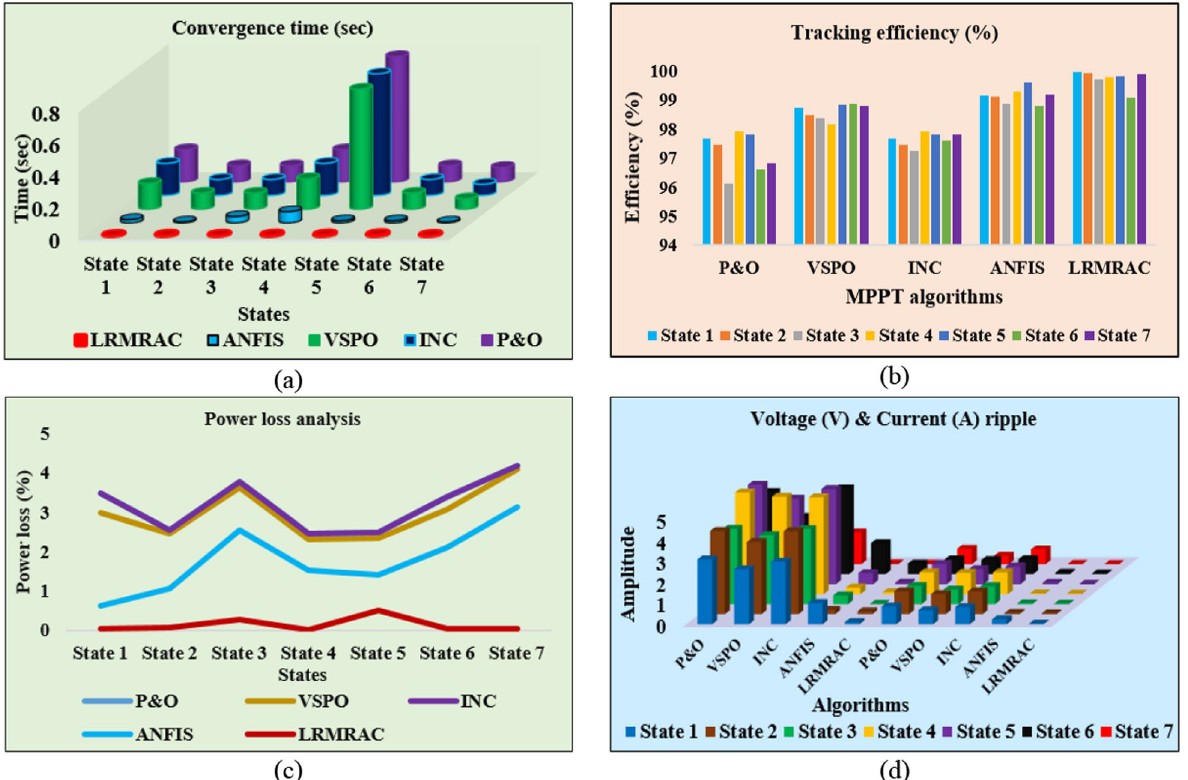
Fig. 15 Comparative evaluation a convergence time b tracking efficiency c power loss d voltage and current ripples